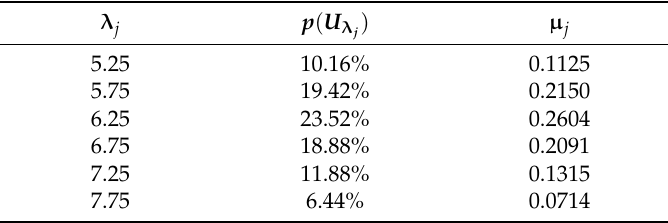
Table 3. Design TSRs and weighting coefficients.